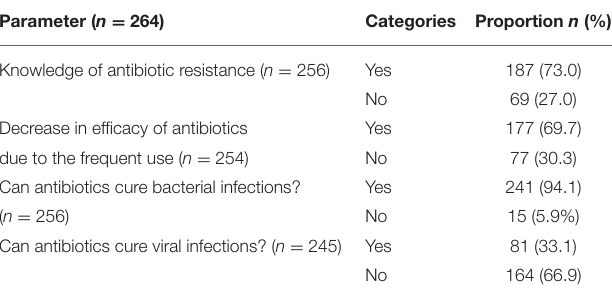
TABLE 3 | Knowledge on antibiotic use among participants.